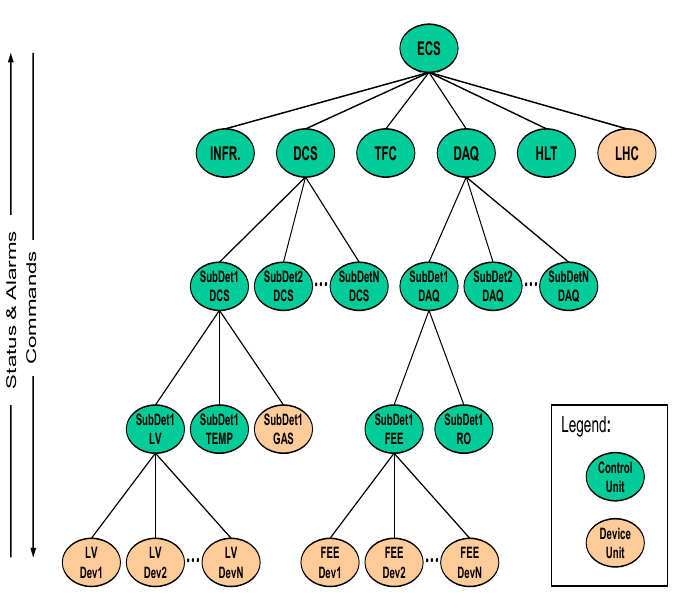
Figure 1. Experiment Control System